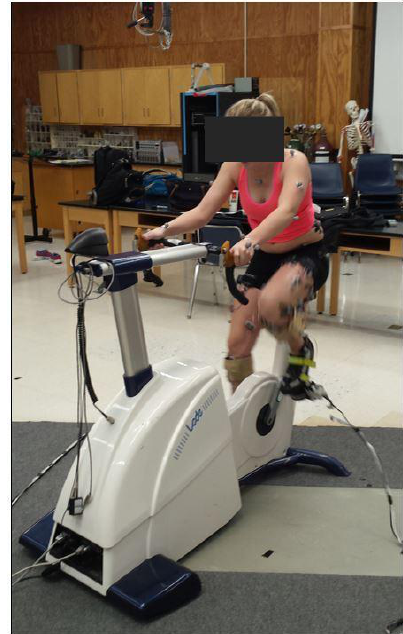
Figure 1. Subject in seated position on ergometer.